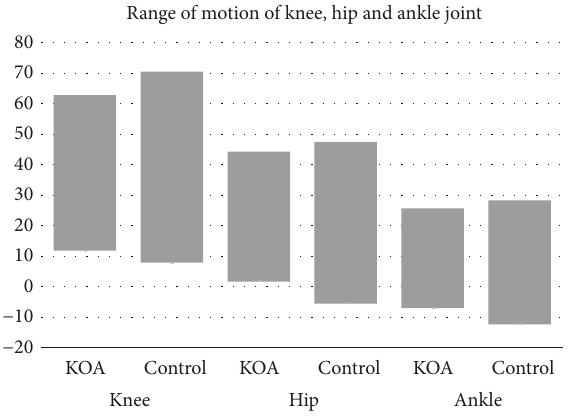
Figure 1: Range of motion (ROM) of the knee, hip, and ankle joint. The knee OA (KOA) group showed smaller ROM than the control group. In the knee joint, a negative value indicates hyperextension. In the hip joint, a negative value indicates extension. In the ankle joint, a negative value indicates plantar